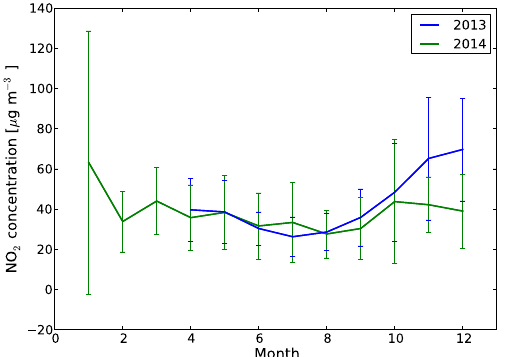
Figure 8. The monthly averaged in situ NO 2 concentration at 13:00 local time in Nanjing for 2013 and 2014. The bar is the standard deviation (natural variability) of the observations for each month (derived from the daily data on